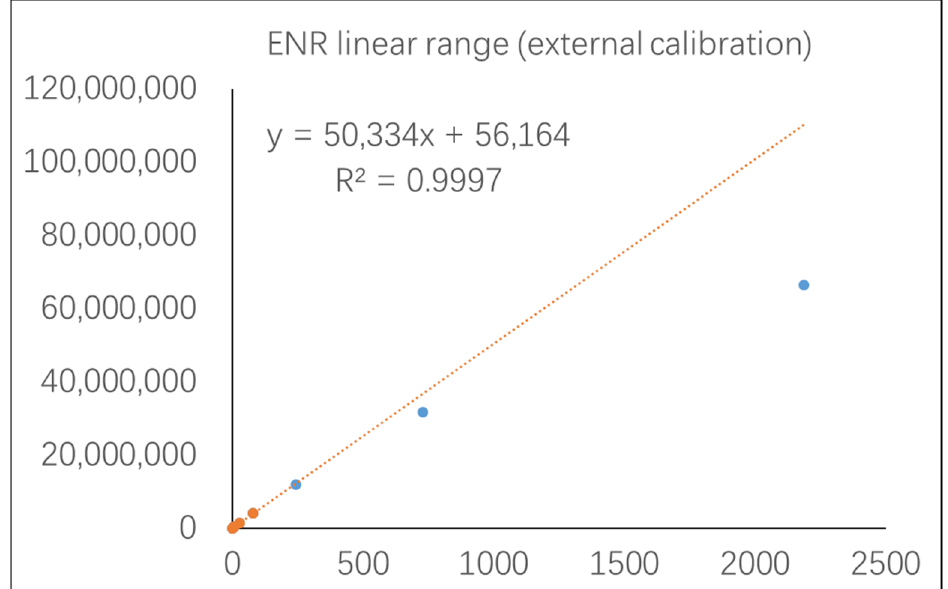
Figure 1. Linear range profile of ENR in the MS detector.